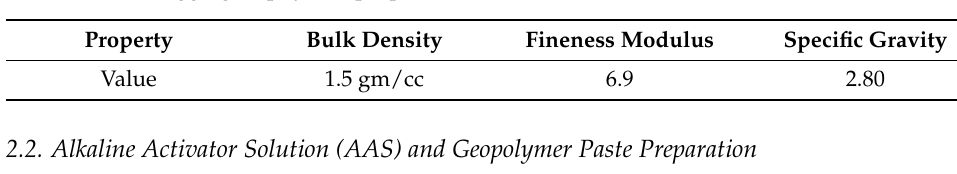
Table 5. Coarse aggregate physical